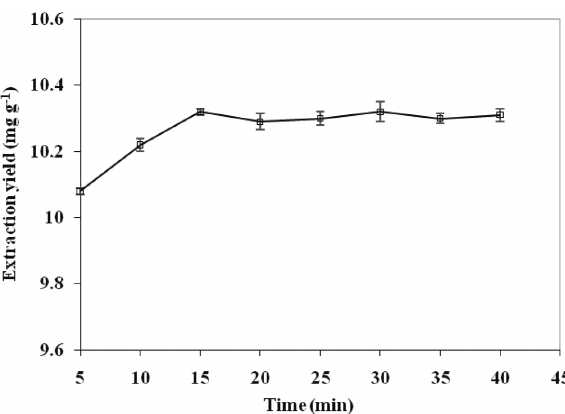
Fig. 4 – Effect of extraction time on the extraction yield of Ginkgo flavonoids. ChCl/LA1 containing 40 % (w/w) water was used as extraction solvent at a solvent to solid ratio of 1:10 with stirring at 50 °C and 150 rpm for different